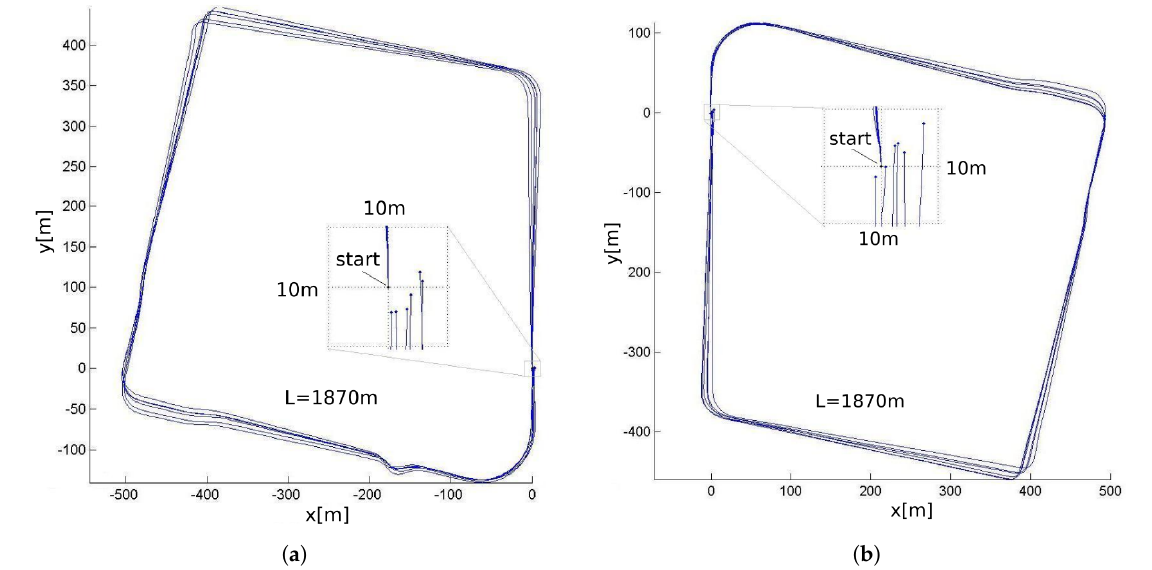
Figure 28. Evaluationof the dead reckoning sensor on a closed path: ( a ) clockwise direction; ( b ) counterclockwise